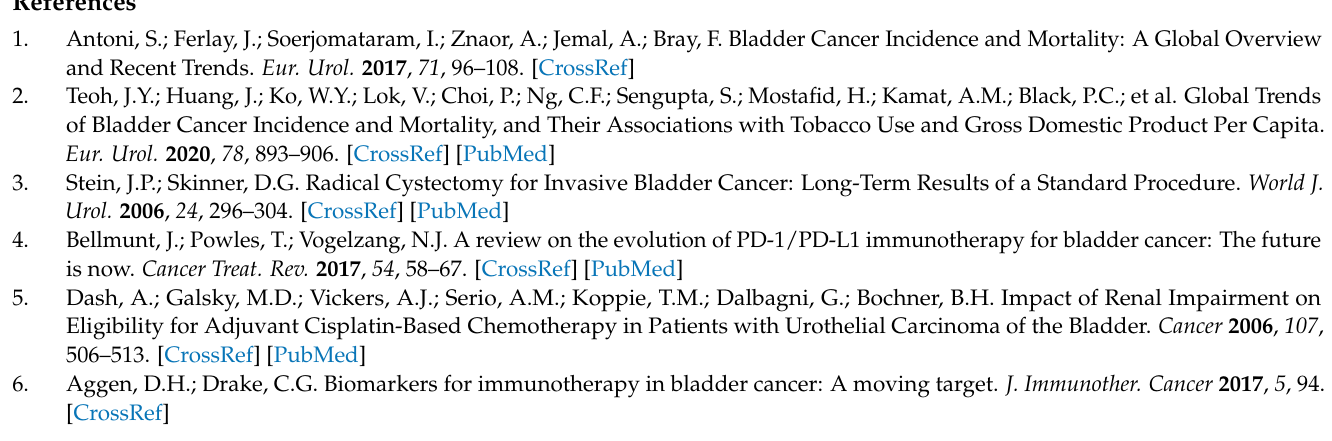
analyses; Table S3: Detailed antibody protocol information for immunohistochemistry; Table S4: Supple- mentary contingency table of all immunohistochemical markers; Table S5: metric correlations for each immune marker, Table S6: dichotomous correlations for each immune